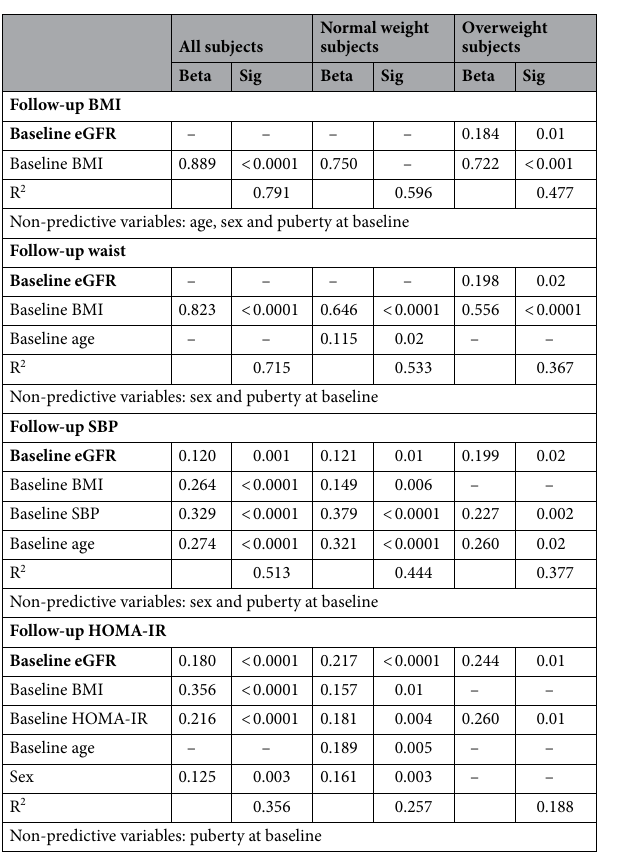
Table 3. Multivariate linear models of baseline eGFR as the independent variable and selected variables at